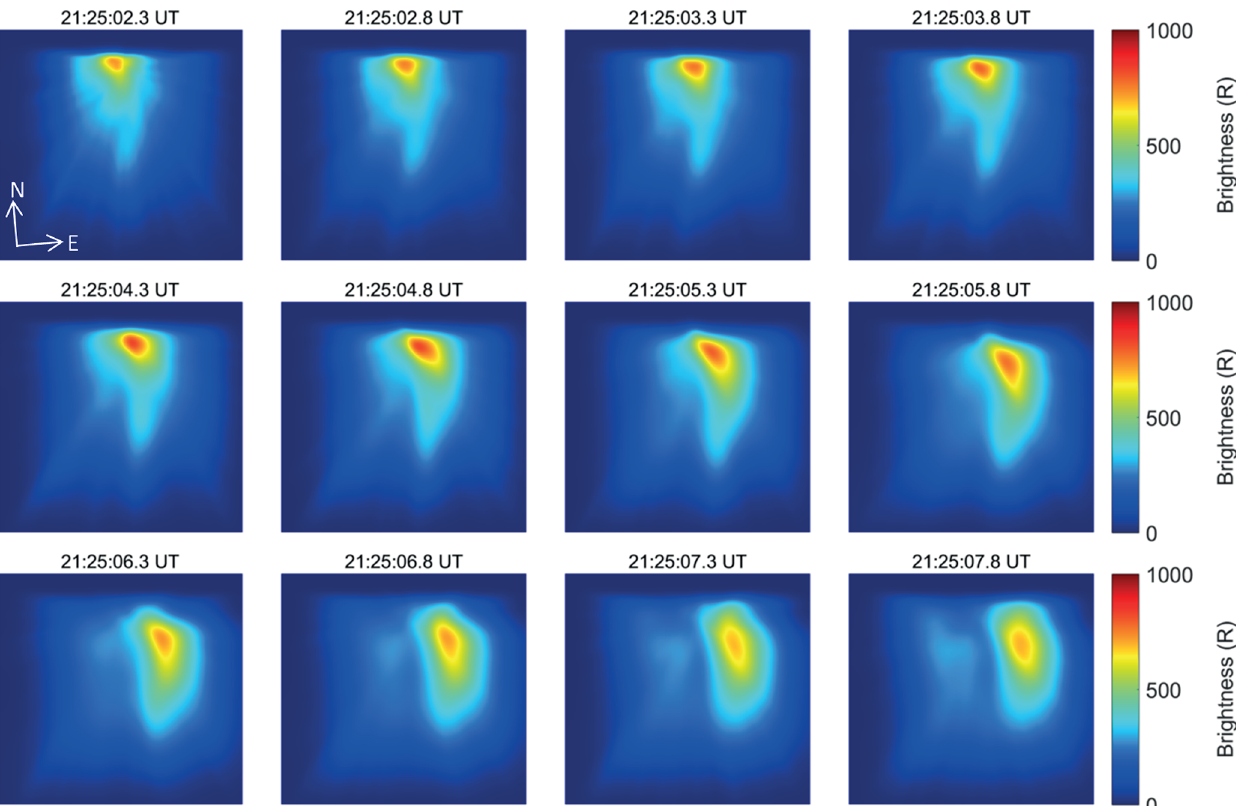
Figure 6. A sequence of modelled images of the 732.0nm emission from the distribution of ions that convect away from their source region.